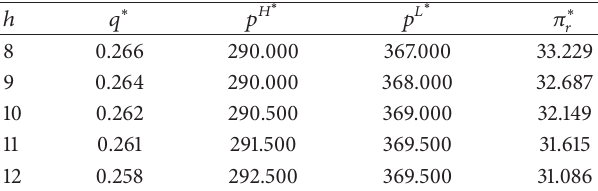
Table 3: Effects of inventory holding cost.